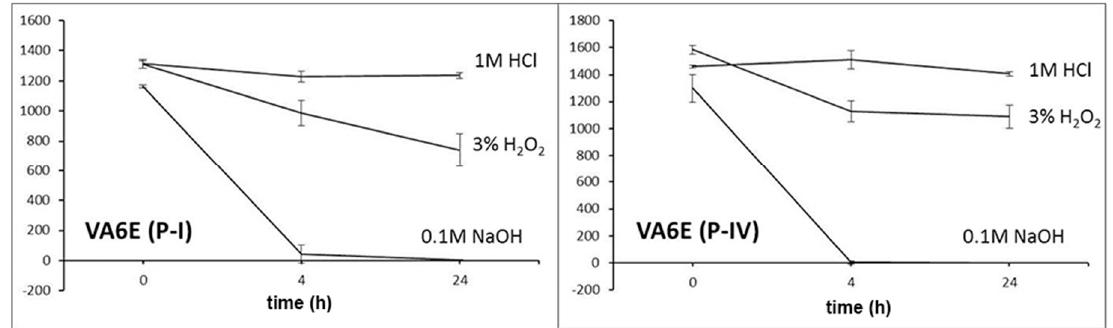
Figure 10 . Stability of compound VA6E (polymorph I and IV) after 0, 4 and 24 h of exposition to HCl, NaOH and H 2 O 2 .